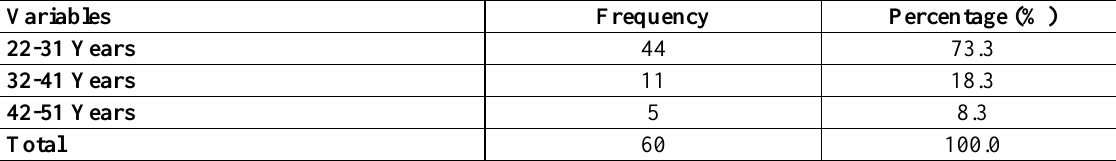
Table 2. Distribution of study group according to age.